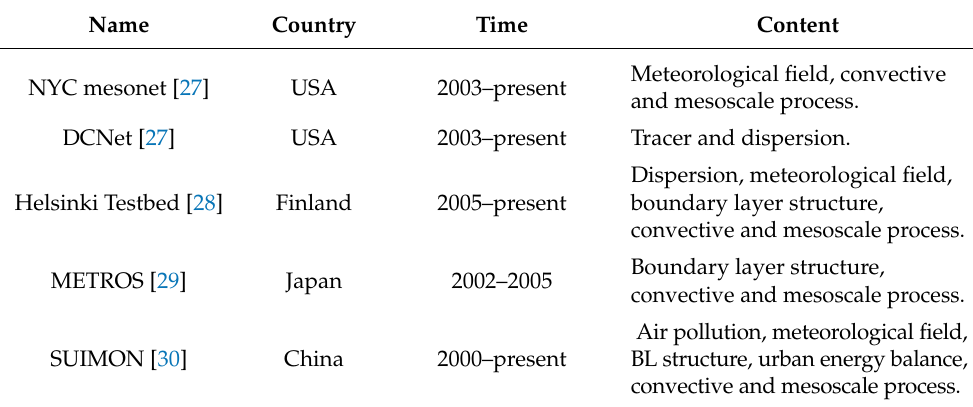
Table 2. Long-term urban meteorological observation